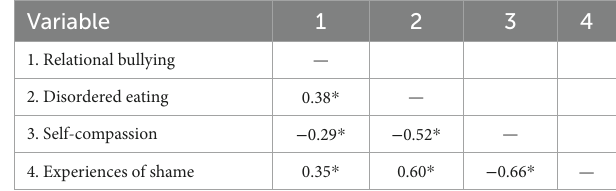
TABLE 2 Correlations between study